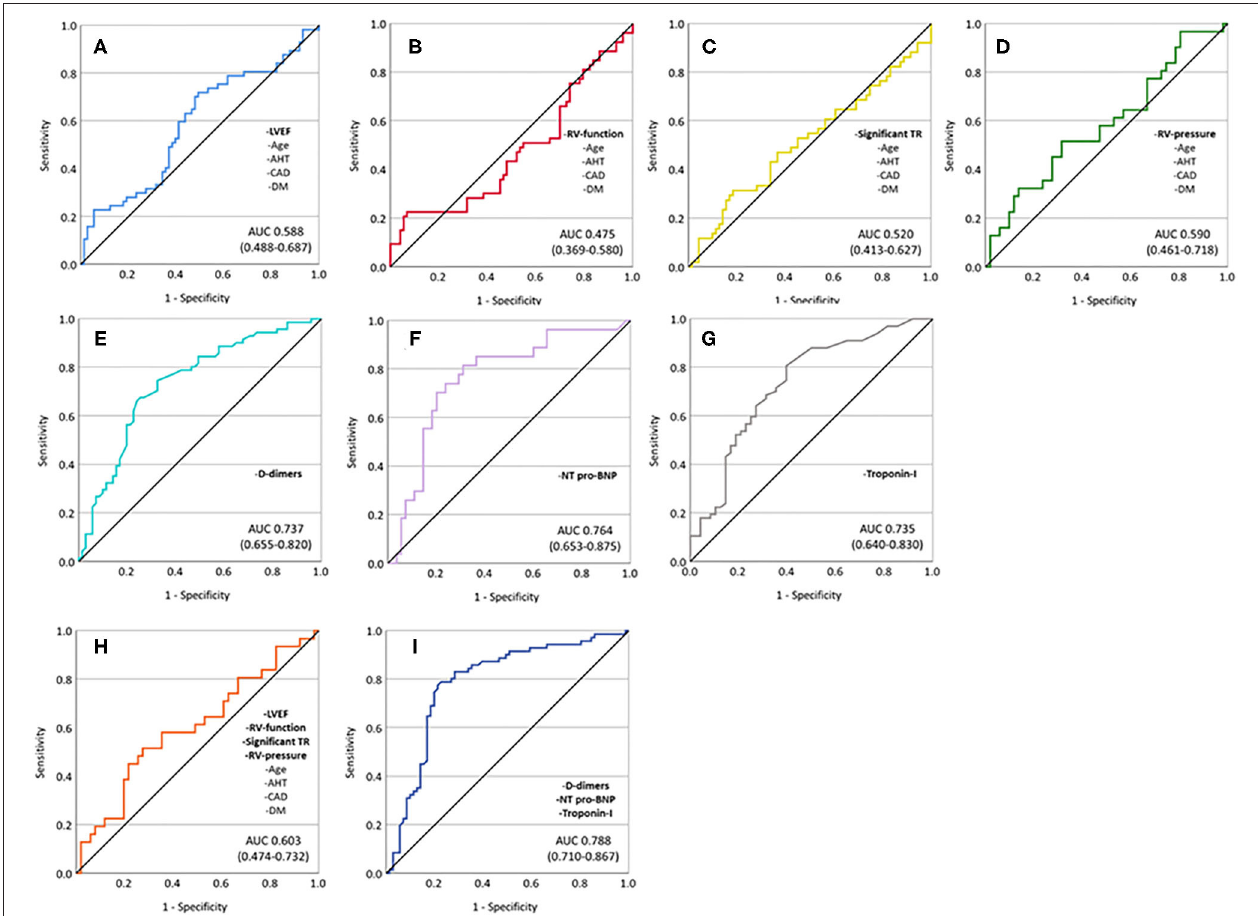
FIGURE 4 | ROC analyses showing predictive performance of different univariate and multivariable models. (A) Age, arterial hypertension, coronary artery disease, diabetes mellitus, and impaired LVEF; (B) age, arterial hypertension, coronary artery disease, diabetes mellitus, and impaired RV-function; (C) age, arterial hypertension, coronary artery disease, diabetes mellitus, and significant TR; (D) age, arterial hypertension, coronary artery disease, diabetes mellitus, and elevated RV-pressure; (E) D-dimers; (F) NT-pro-BNP; (G) troponin-I; (H) age, arterial hypertension, coronary artery disease, diabetes mellitus, impaired LVEF, impaired RV-function, significant TR, and elevated RV-pressure; and (I) D-dimers, NT-pro-BNP, and